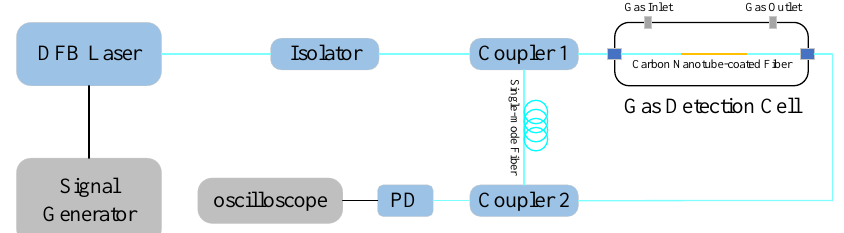
Figure 2. The FLRD system for gas detection.